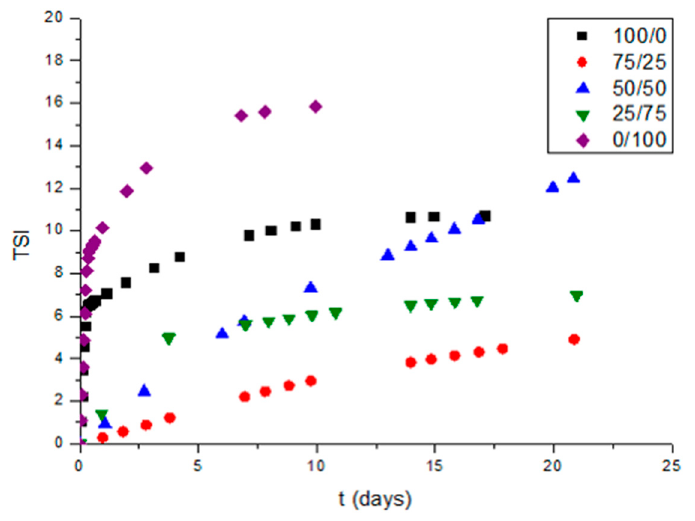
Figure 7. Values of Turbiscan Stability Index (TSI) with aging time for mandarin nanoemulsions as a function of Tween80/Span80 ratio.